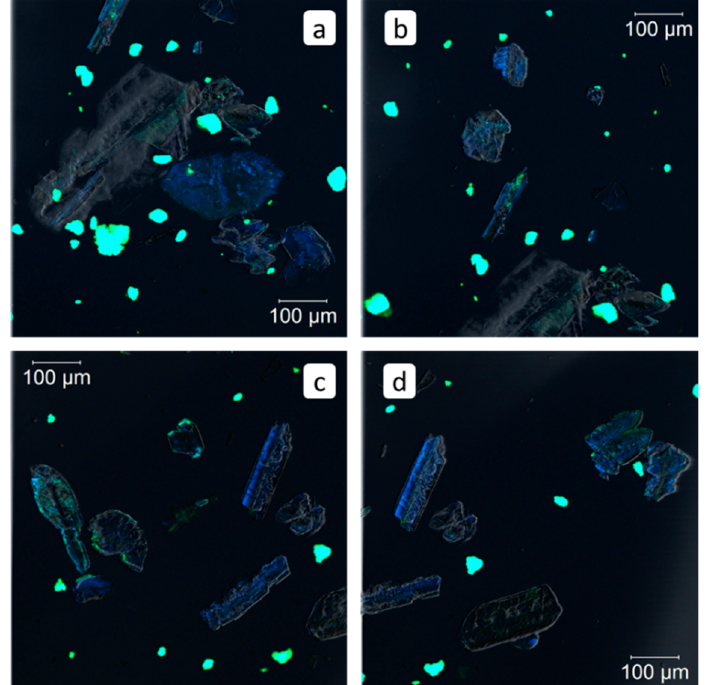
Figure 8. Fluorescent images of the liquid phase of a gypsum solution with 10 mg·dm − 3 PAA- Figure8. Fluorescentimagesoftheliquidphaseofagypsumsolutionwith10mg · dm − 3 PAA-F2 / HEDP-F F2/HEDP-F blend (1:1 mass) after 24 h thermal treatment (NACE Standard), obtained by a blend (1:1 mass) after 24 h thermal treatment (NACE Standard), obtained by a superposition of three superposition of three channels detection modes (HEDP-F—blue, PAA-F2—green, and transmitted channels detection modes (HEDP-F—blue, PAA-F2—green, and transmitted laser light—grey) taken at laser light—grey) taken at different points ( a – d ). Scale marker corresponds to 100 µm. di ff erent points ( a – d ). Scale marker corresponds to 100 µ